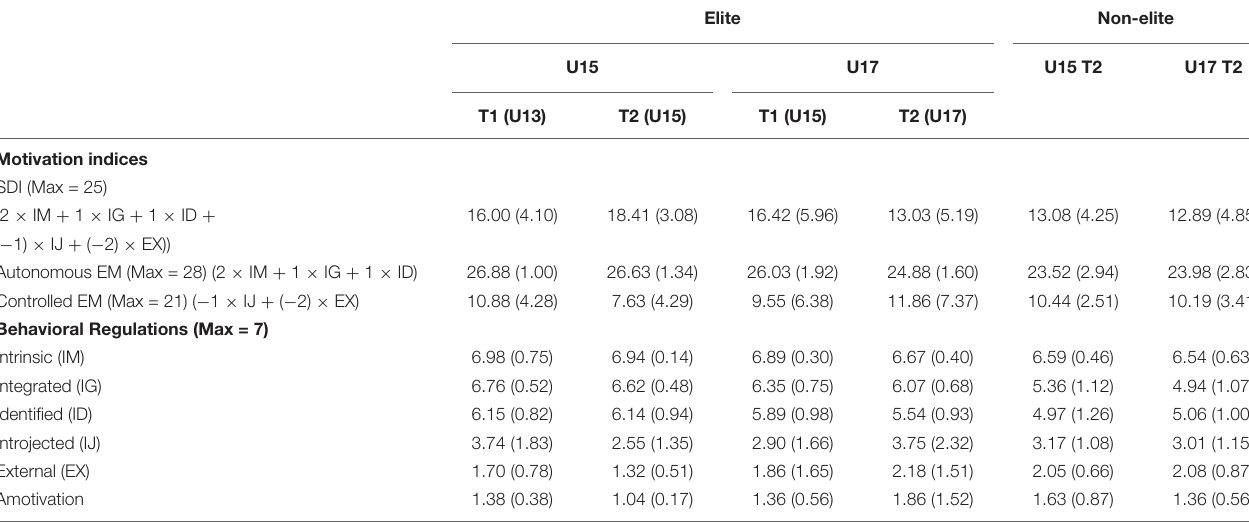
TABLE 2 | Mean (and SD) self-determined motivation scores of the current U15 and U17 elite and non-elite soccer players at time 1 (T1) and time 2 (T2). Elite